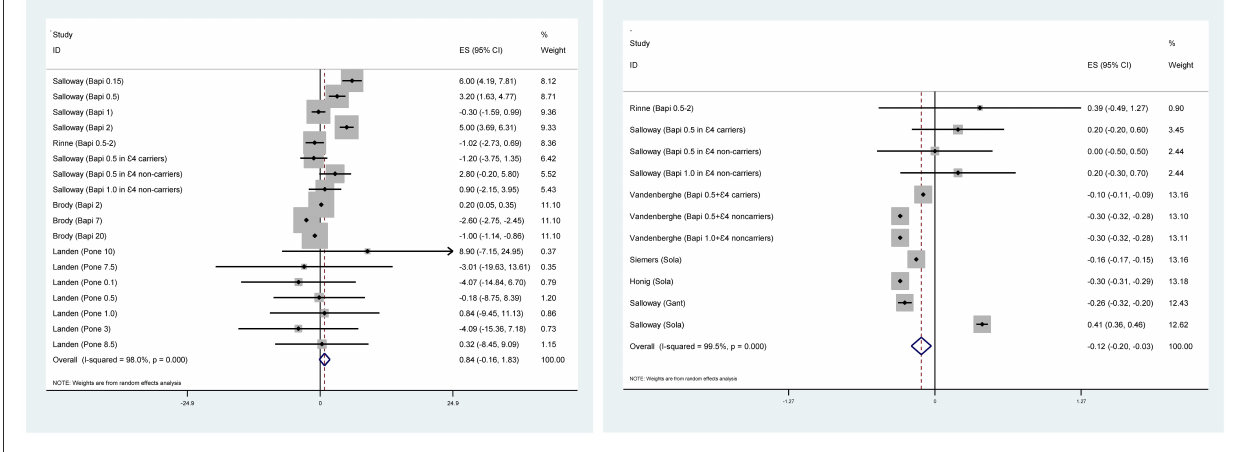
FIGURE2 Forest plots of four assessment scales for monoclonal antibodies against A β vis-à-vis placebo in the treatment of mild or moderate Alzheimer’s